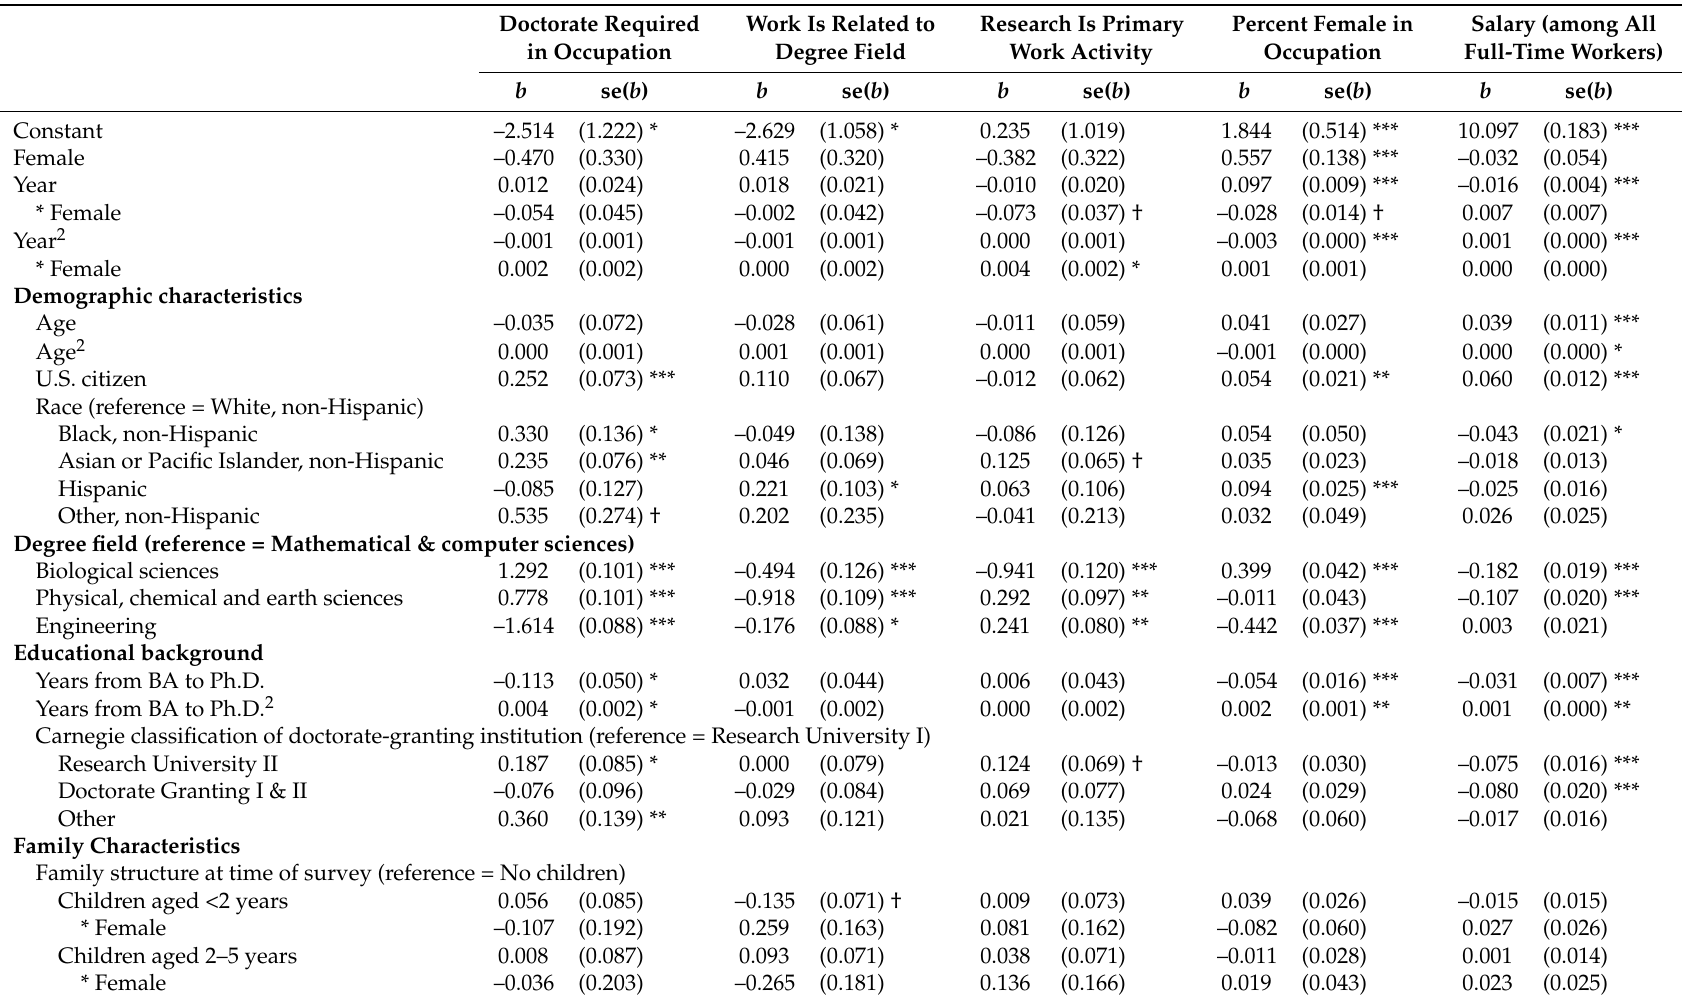
Table A5. Estimated coefficients from regression models of job characteristics and salary among full-time employed STEM